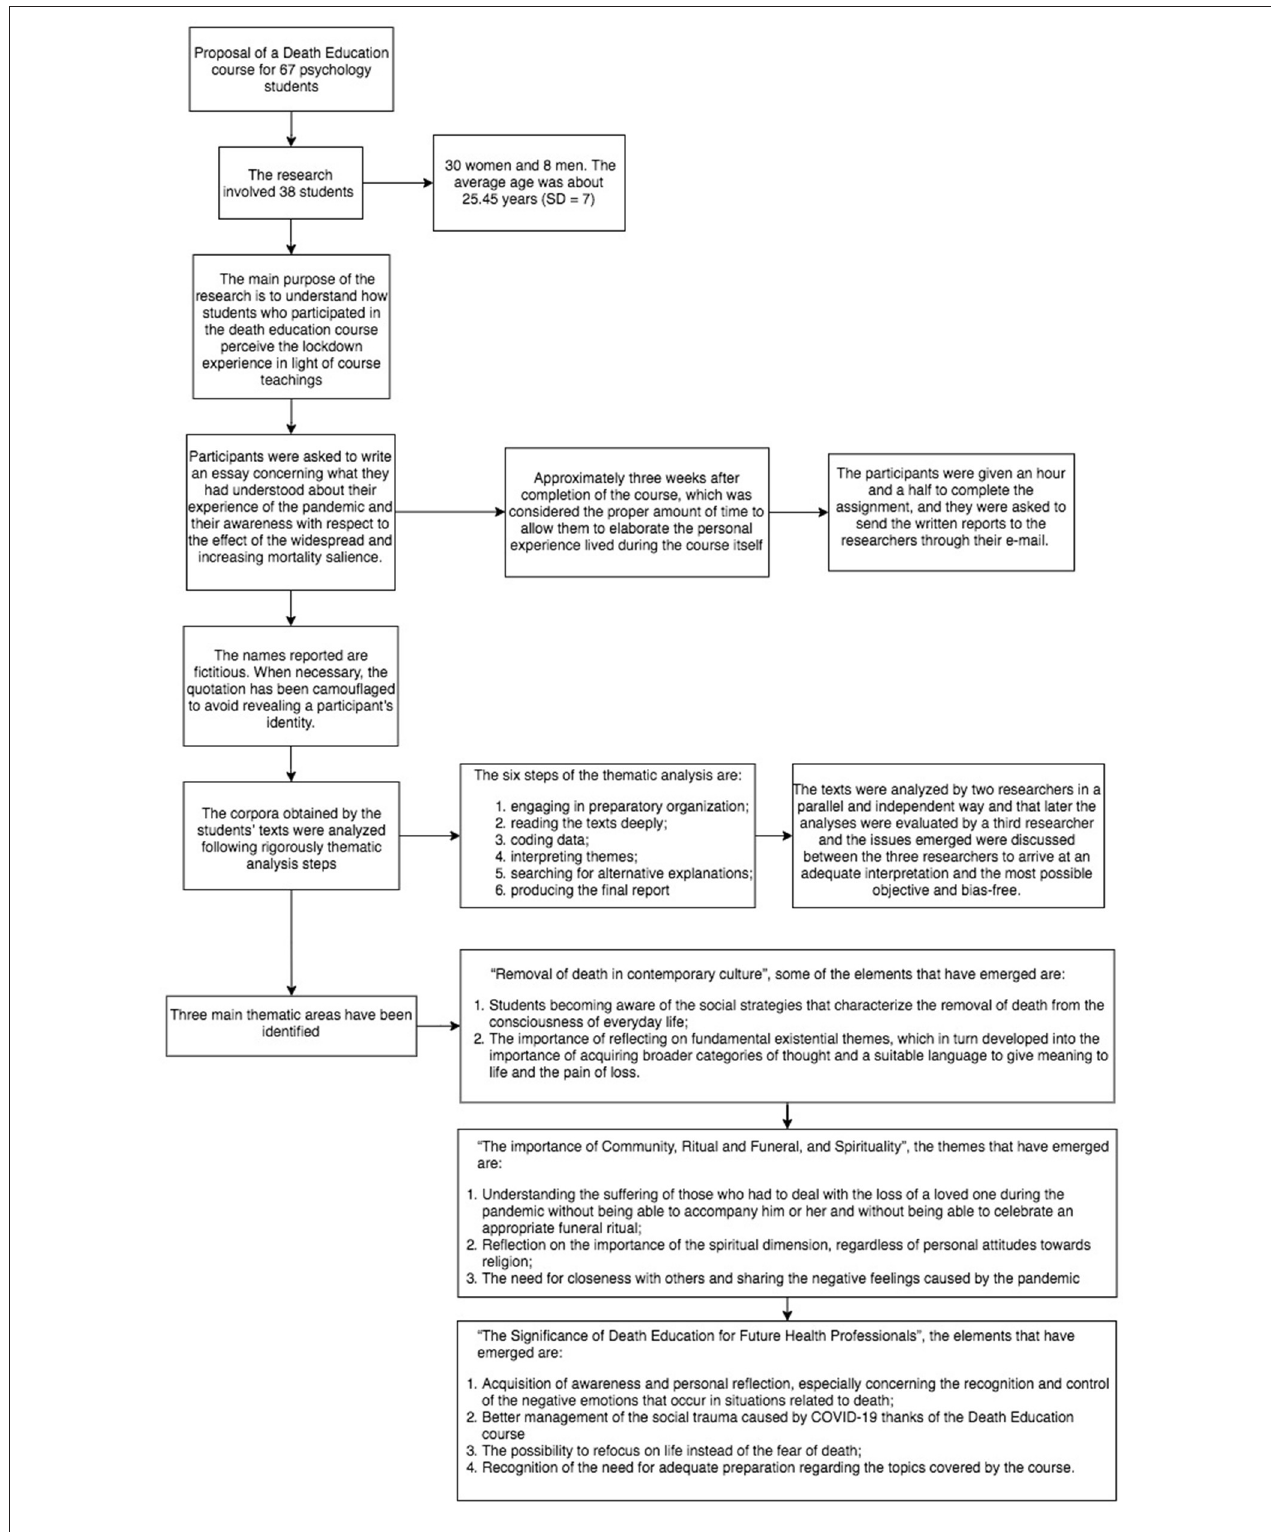
FIGURE 1 | Flowchart describing the phases of the study.